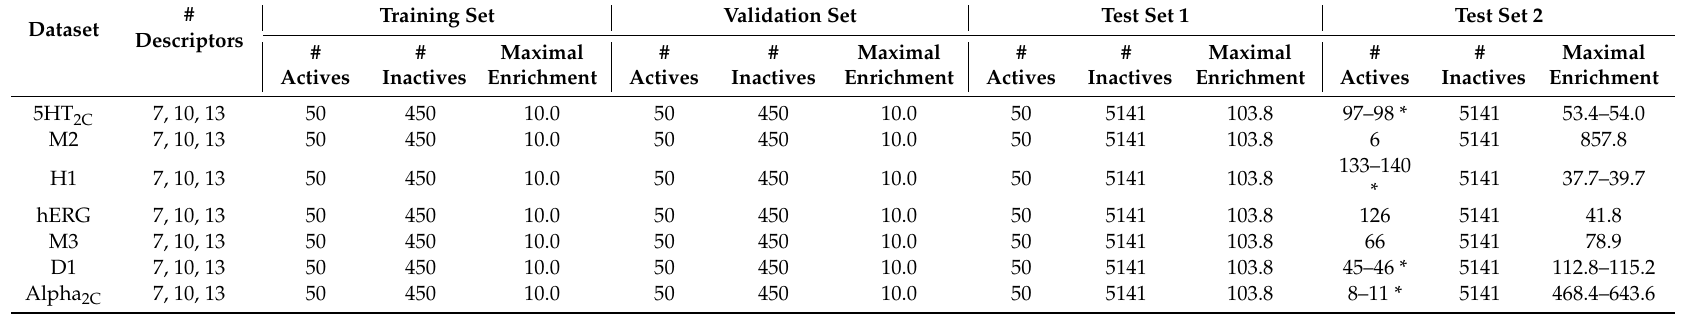
Table 6. Description of the four datasets used for the derivation of Random Forest (RF) and Support Vector Machine (SVM) models. The “Maximal Enrichment” column provides the maximal possible enrichment at L , attainable for the data set for a comparison with the enrichment values provided in Tables 3 and